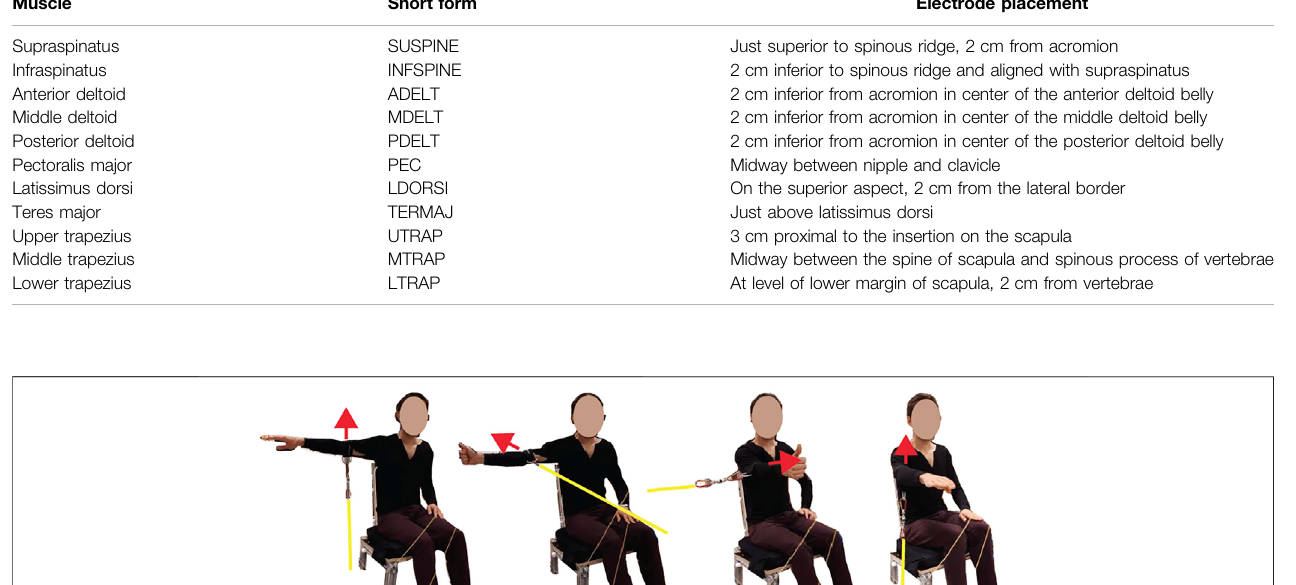
TABLE 2 | Approximate EMG surface electrode placements, including the short forms used in the present paper. Manual palpation was used to fi nd the muscle fi bers of interest with the following as a guide. Muscle Short form Electrode placement